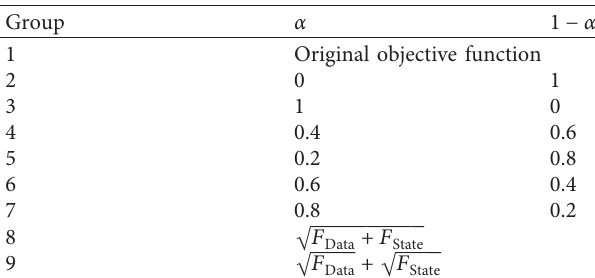
Figure 14: The single and regular-shaped scatterer. Table 1: The different settings of